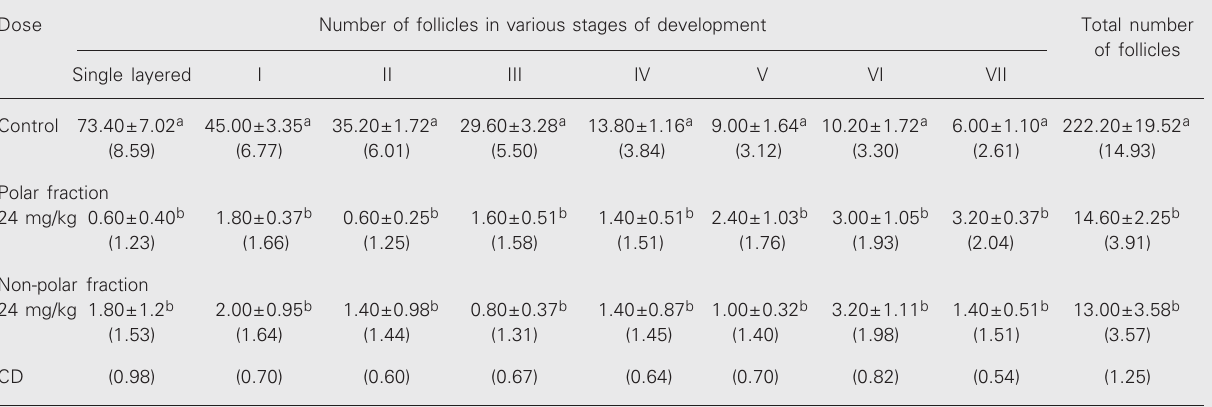
Table 2. Number of normal follicles in various stages of follicular development in the ovaries of albino rats treated orally with polar fraction and non-polar fraction of Melia azedarach (dharek) seed extract. Dose Number of follicles in various stages of